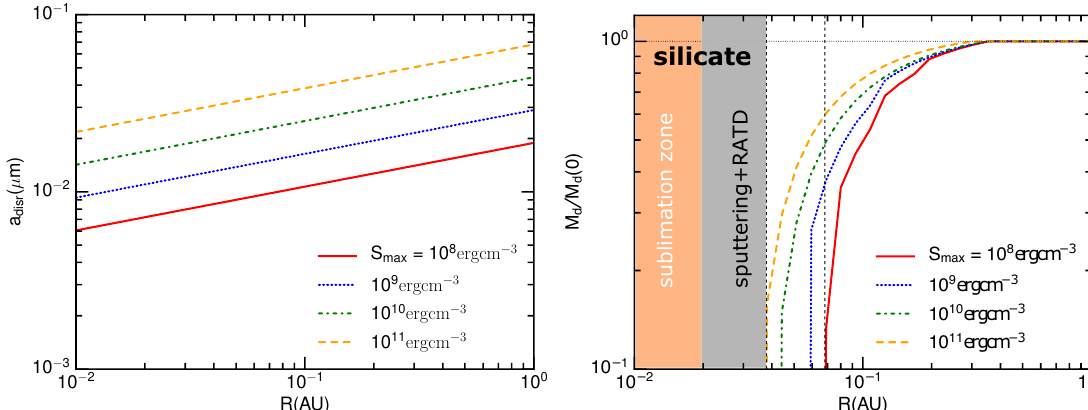
Figure 27. Left panel: Grain disruption size by RATD as a function of heliodistance for the different tensile strength. Large grains are disrupted by RATD into very small grains. Right panel: Decrease of the dust mass ( M d / M d ( 0 ) ) with heliocentric distance due to RATD and nonthermal sputtering by the solar wind for silicate grains where M d ( 0 ) is the original dust mass. Four values of the tensile strength S max = 10 8 –10 11 ergcm − 3 are considered. The dust mass decreases toward the Sun, starting from 0.2 AU(for highest strength) and reaches the new dust-free-zone predicted by RATD and sputtering ∼ effects (gray shaded